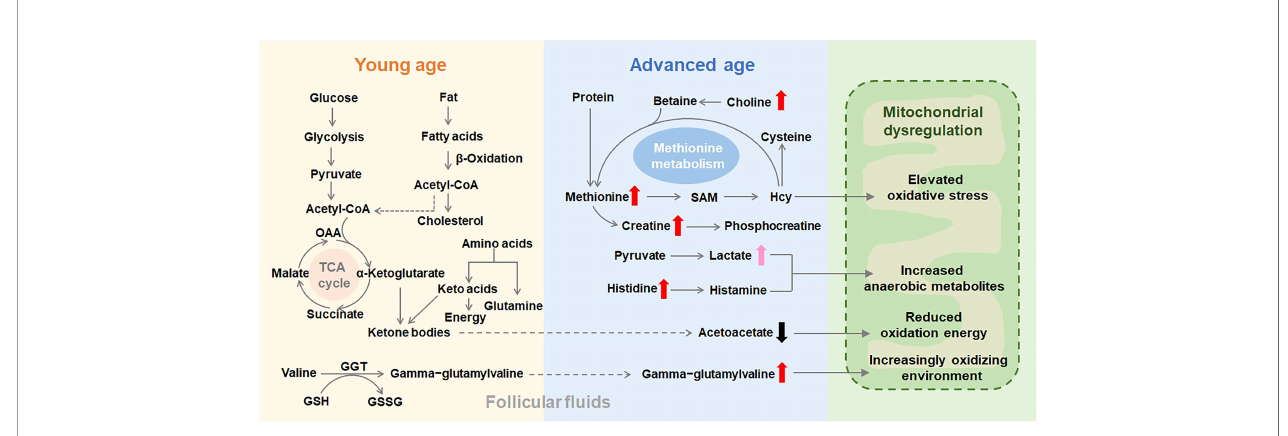
FIGURE 5 | Schematic representation of the metabolic pathways that are putatively altered in follicular fl uids as age advances. Thick and short arrows indicate the variation in metabolite concentrations in follicular fl uids from women with advanced age compared with their concentrations in the young age group. A dysfunctional mitochondrial metabolism could explain the observed accumulation of identi fi ed metabolites in the follicular fl uids of advanced age women. SAM, S-adenosylmethionine; Hcy, homocysteine; GSH, glutathione; GSSG, oxidized glutathione; GGT, gamma-glutamyltransferase; OAA, oxaloacetic acid; TCA cycle, tricarboxylic acid